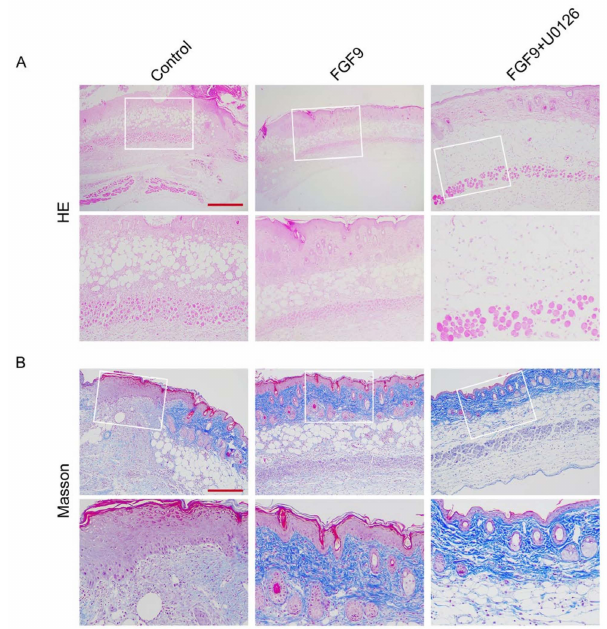
Figure 3. Treatment with FGF9 led to better flap histological condition. ( A ) HE staining photographs of control, FGF9, and FGF9+U0126 groups. Magnification = 4 × ; scale bar = 500 µ m. The white- bordered region was captured at high magnification as the illustrative photograph; scale bar = 200 µ m. ( B ) Blood vessels and collagen fibers were visualized by Masson trichrome stain photographs of each